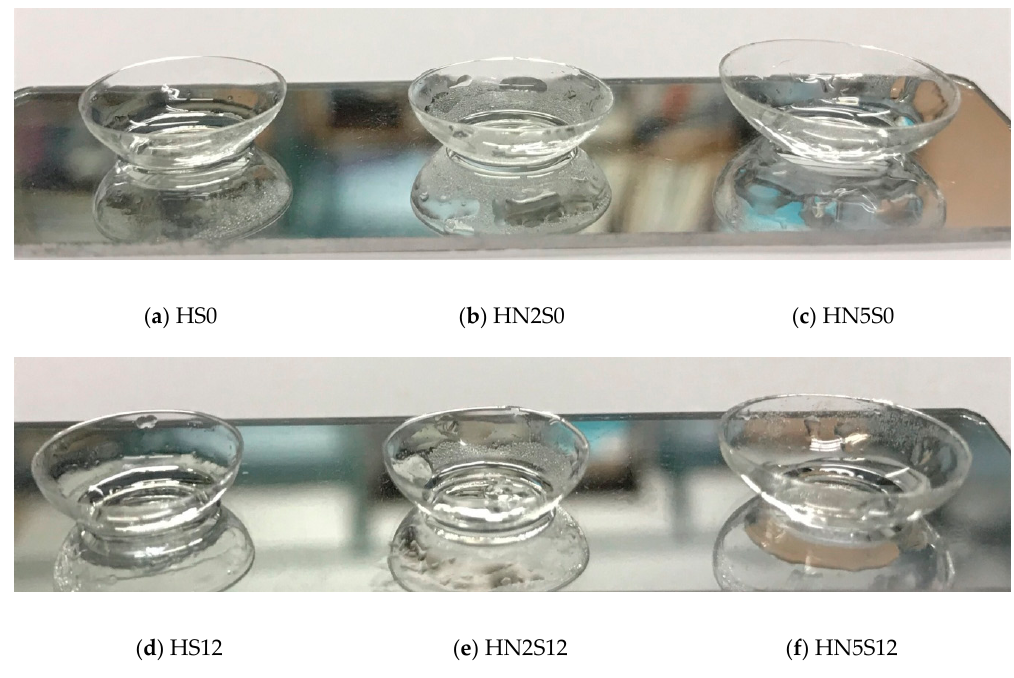
Figure 8. Photos of hydrated contact lenses.